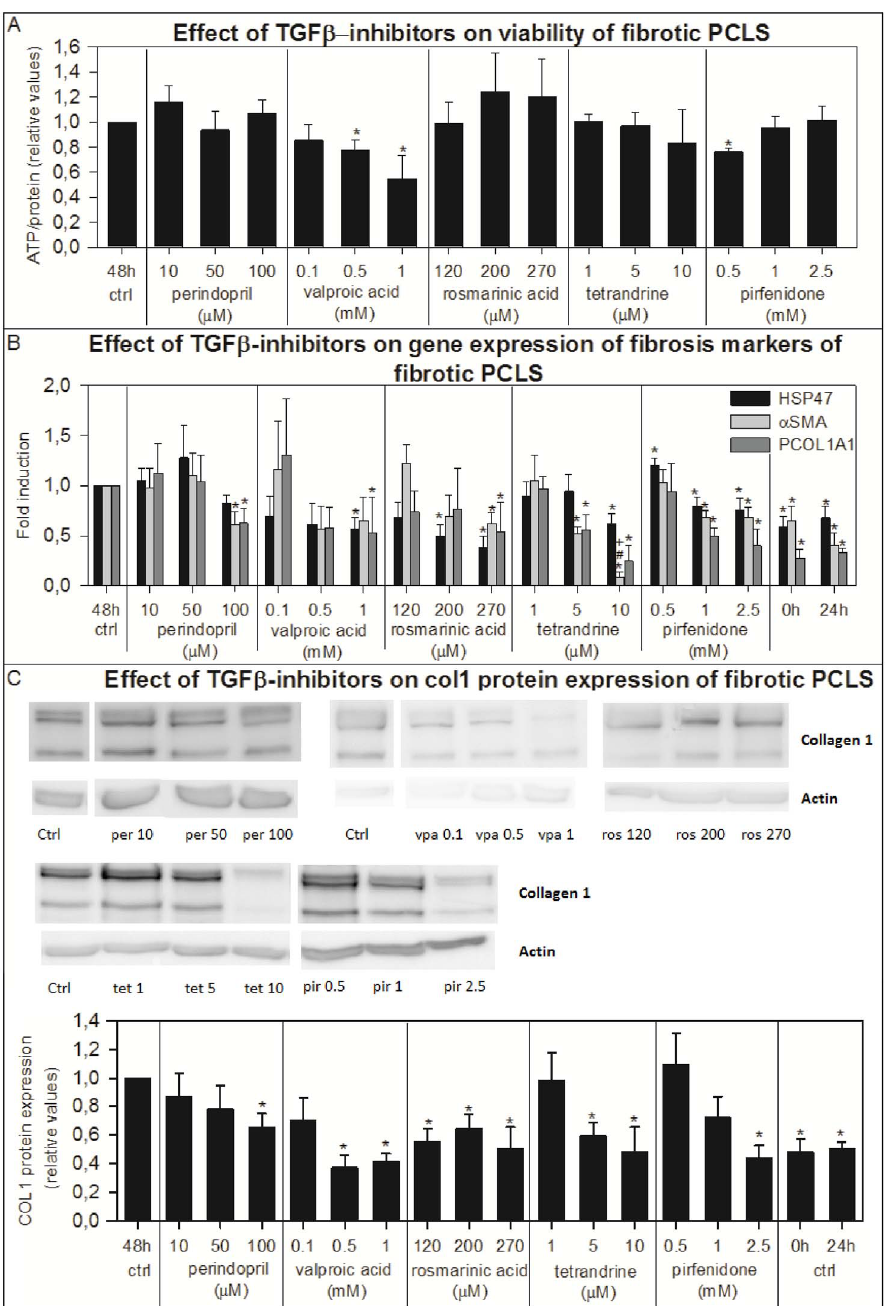
Figure 5. The effect of TGF b -inhibitors in fPCLS on viability, gene expression of fibrosis markers and collagen 1 protein expression. The effect of TGF b -inhibitors perindopril (n=5), valproic acid (n=4), rosmarinic acid (n=4), tetrandrine (n=4) and pirfenidone (n=5) on the viability (A), on the gene expression of fibrosis markers Hsp47 , a Sma and Pcol1A1 (B) and on the collagen 1 protein expression (pictures are from a representative experiment) (C) of fPCLS from livers from BDL rats incubated for 48 hours. Error bars represent SEM. Significant decrease: *p , 0.05 vs 48h, # p , 0.05 vs 0 hours, + p , 0.05 vs 24 hours.